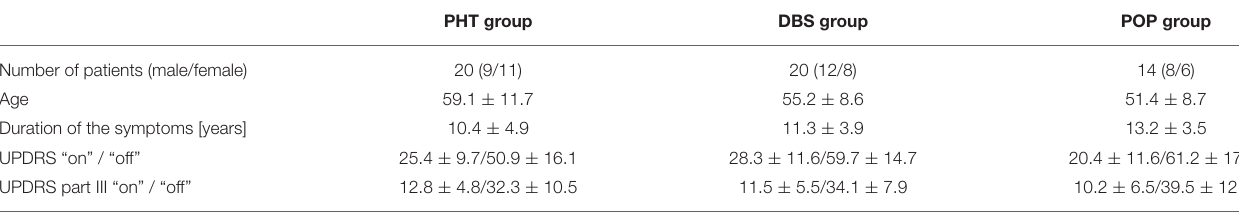
TABLE 1 | Baseline characteristics of the study population at the time of inclusion.